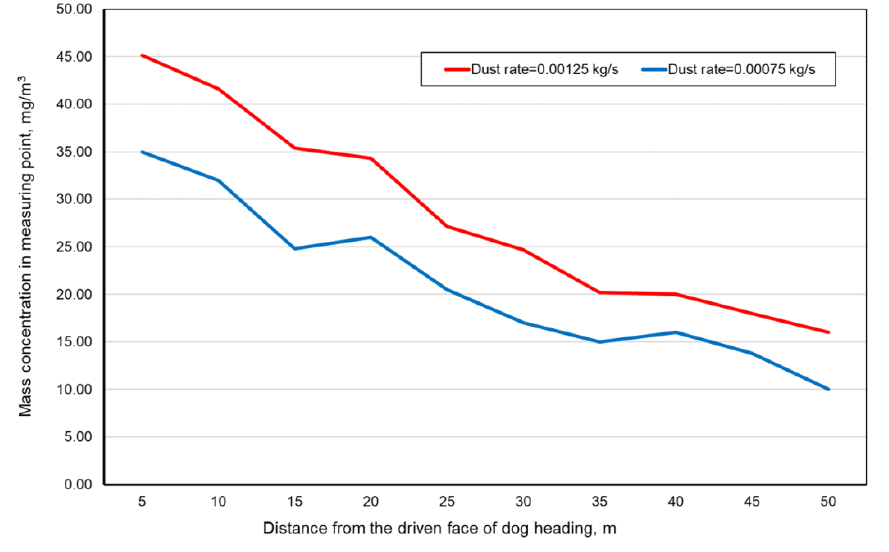
Figure 9. Distribution of dust concentration along the adopted measurement lines for studied var- iants.